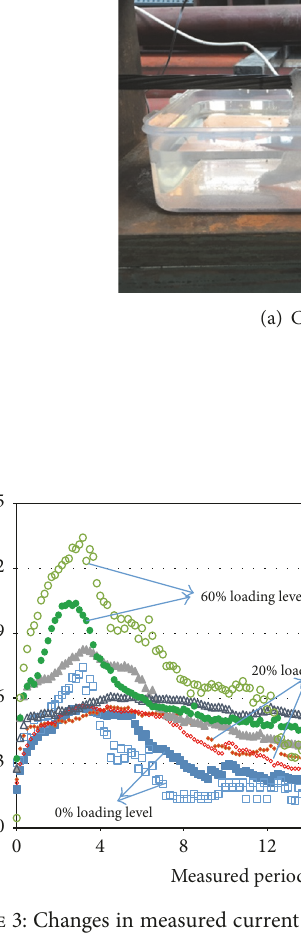
Figure 4: Summation of measurements with different prestressing level.